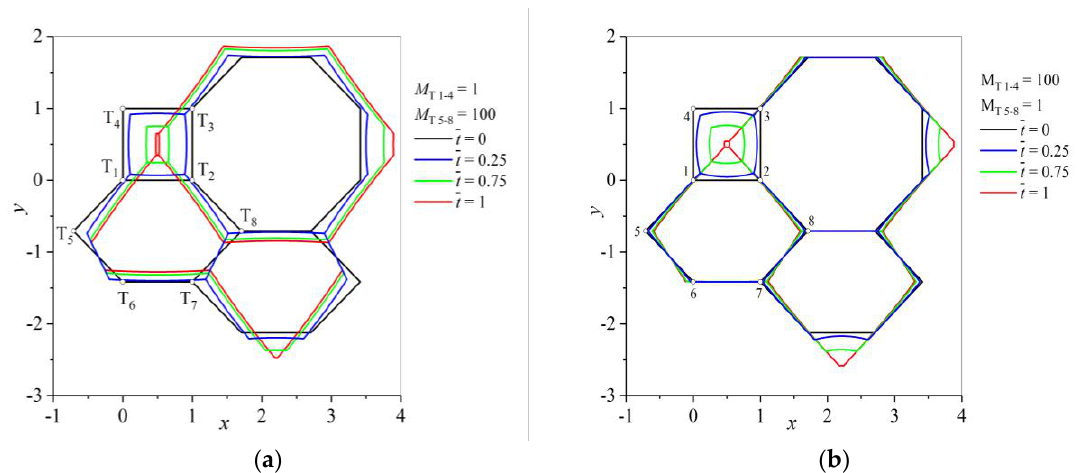
Figure 6. Evolution of the grain arrangement for different normalized times t . ( a ) Case I: The mobilities M T 1–4 are set to the comparatively small value 1, M T 5–8 are set to 100. ( b ) Case II: The mobilities M are set to the comparatively small value 1, whereas, 5 8 T